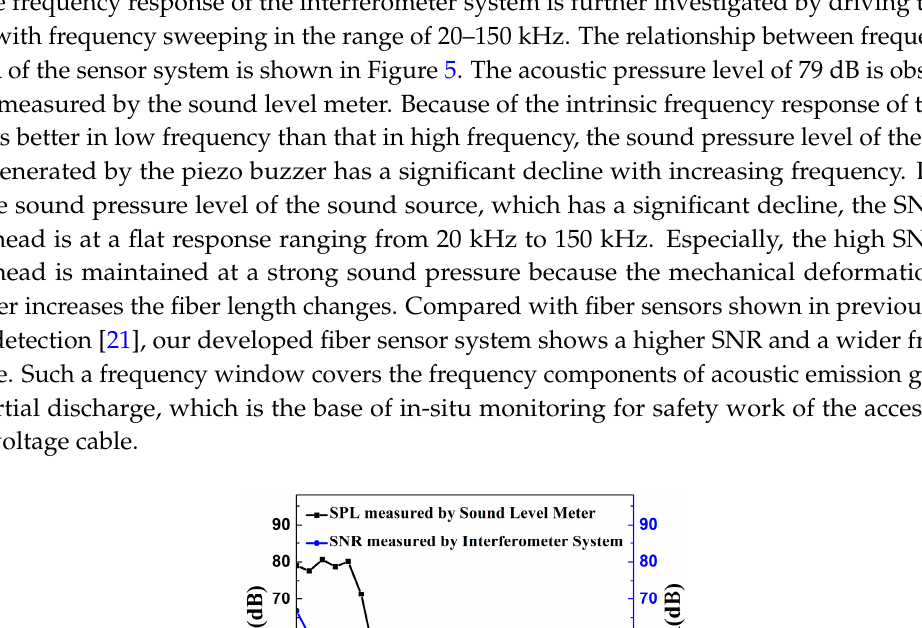
Figure 6. Experimental setup of the partial discharge of copper wires.